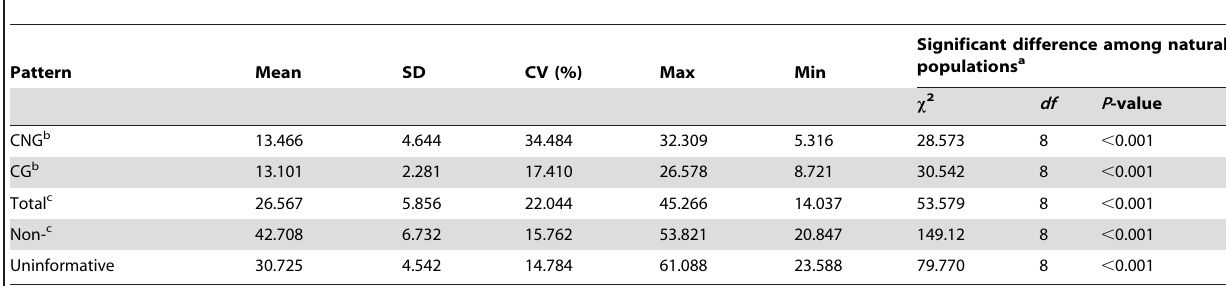
Table 2. Relative genomic methylation/non-methylation levels in the natural populations of Populus tomentosa.